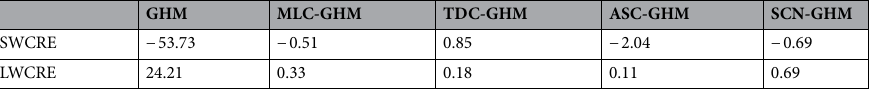
Table 3. Globally averaged shortwave and longewave TOA cloud radiative effects for the GHM case, as well as the differences between various cases and the GHM. Unit: Wm −2